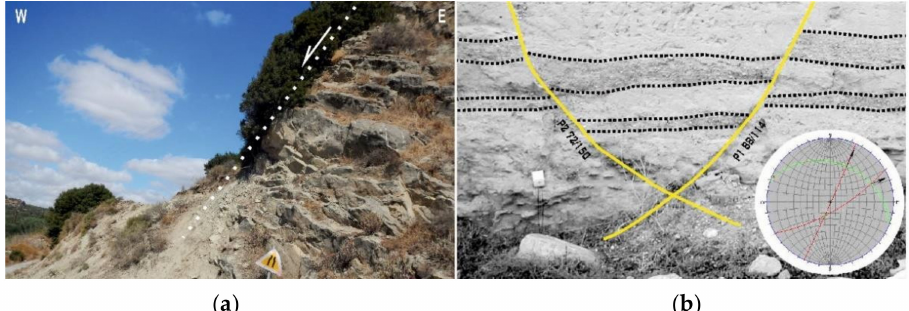
Figure 6. Field photographs of ( a ) the Lagouta normal fault, which comprises the southern segment of the Kastelli fault zone, and ( b ) a pair of conjugate syn-sedimentary faults, within Tortonian deposits, compatible with left-lateral strike-slip faulting.